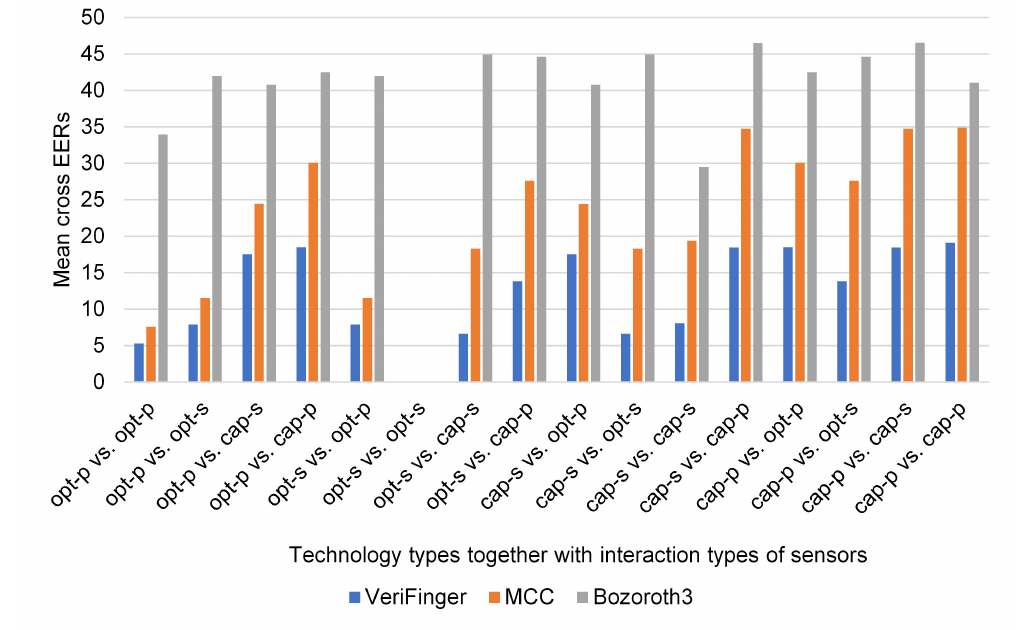
Figure 11. EERs of the three methods for technology types together with interaction types of